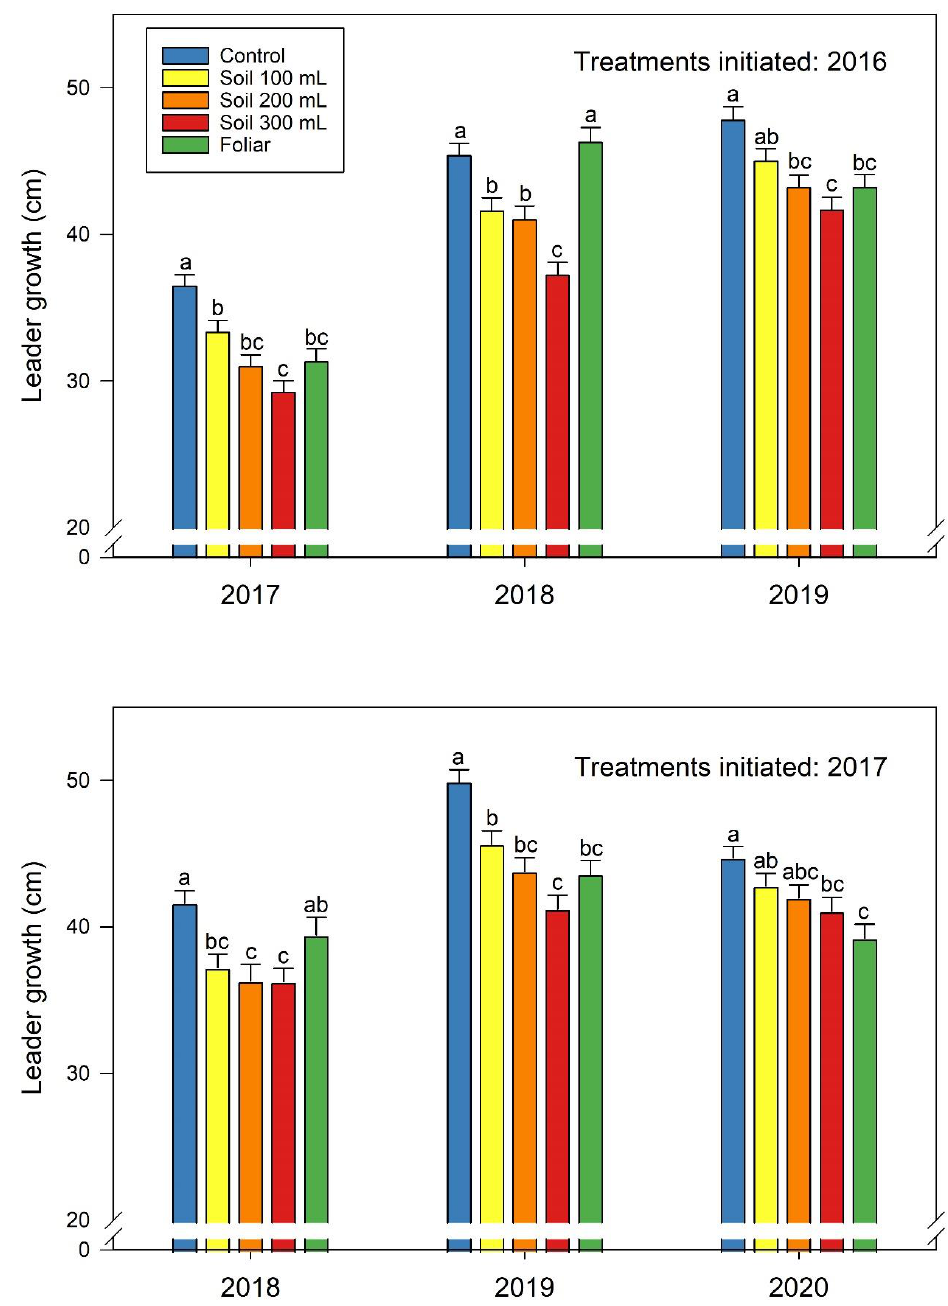
Figure 4. Mean annual leader growth of Fraser fir trees treated with three rates soil applied paclobutrazol, treated with foliar applied paclobutrazol, or left untreated (Control). Top: trees treated with soil application in 2016 or foliar-treated annually 2016–2018. Bottom: trees treated with soil application in 2017 or foliar-treated annually 2017 – 2019. Means within a year indicated by the same letter are not different at p < 0.05 . Mean separation by Tukey’s HSD test.